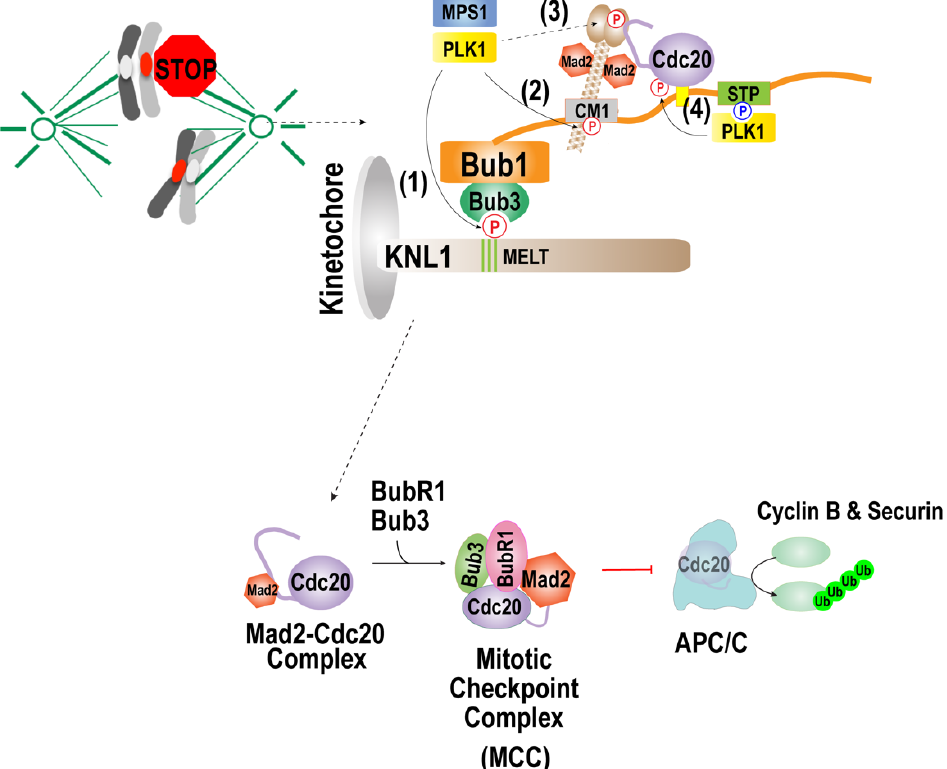
Figure 3. Function of the PLK1 in spindle assembly checkpoint activation. Reprinted/adapted with permission from Ref. [133], 2021, Taekyung Kim. When kinetochores are not attached to the microtubules, PLK1 activates the checkpoint by phosphorylating (1) MELT motifs of KNL1 and (2) the CM1 motif of Bub1, (3) C-terminal region of Mad1, and (4) Cdc20. The PLK1 can substitute Mps1 kinase in phosphorylating MELT motifs of KNL1, which promotes kinetochore localization of the Bub1/Bub3 complex and the CM1 motif of bub1, mediating the interaction with Mad1. PLK-1 in C. elegans was shown to phosphorylate the C-terminal region of Mad1, which promotes the interaction with Mad1. PLK1 that interacts with Bub1 activates the MCC formation by phosphorylating Cdc20. In addition to substituting for Mps1 activity, PLK1 activates Mps1 by phosphorylating multiple sites of Mps1, although whether such phosphorylation directly activates Mps1 is unclear